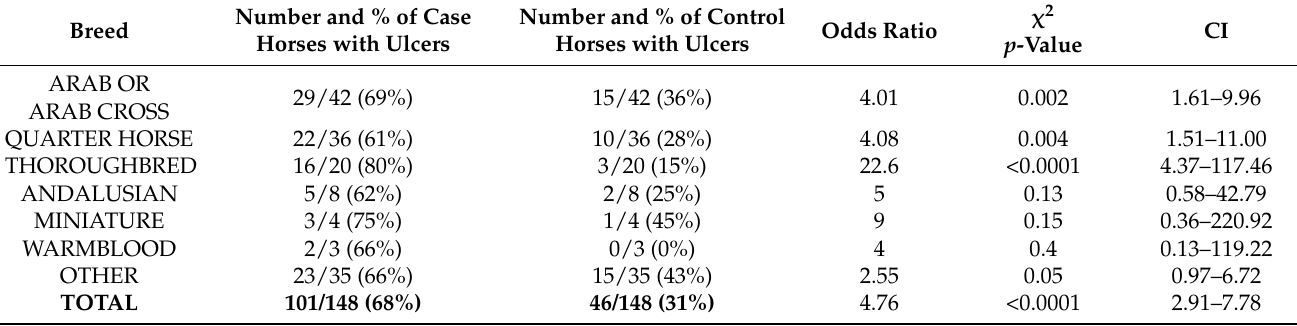
Table 1. Comparative distribution of gastric ulcers in cases and controls amongst different